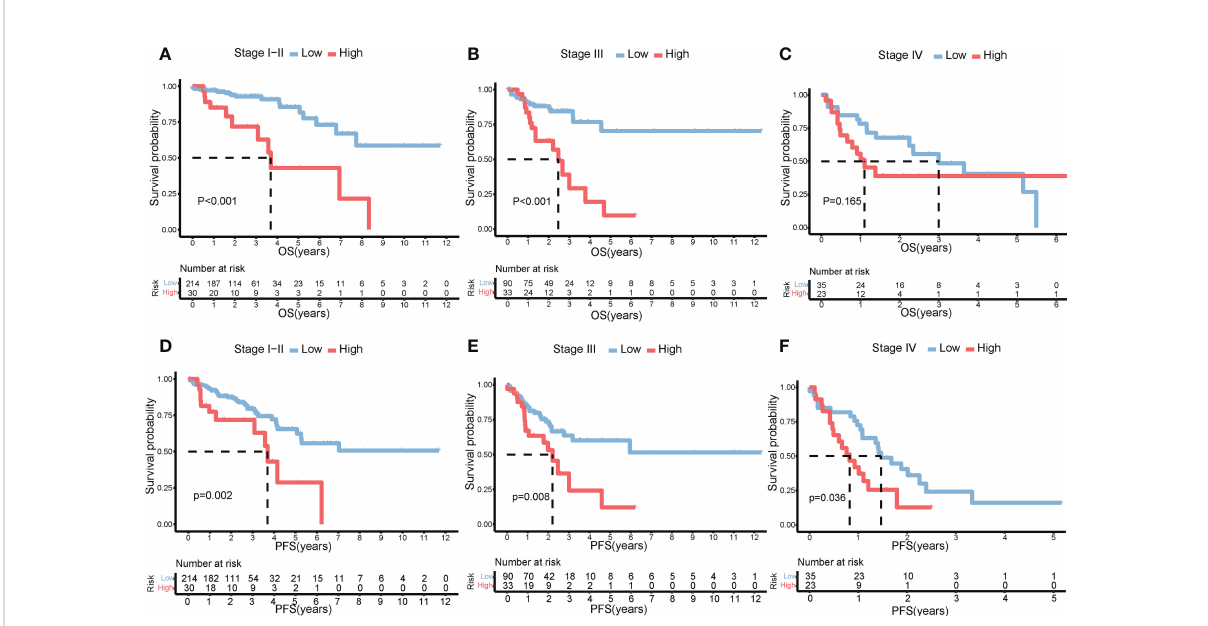
FIGURE 5 Impact of risk score on prognosis by subgroup analysis. OS differences between the high- and low-risk groups in stages I – II (A) , stage III (B) , and stage IV (C) . PFS differences between the high- and low-risk groups in stages I – II (D) , stage III (E) , and stage IV (F) . OS, overall survival; PFS, progression-free